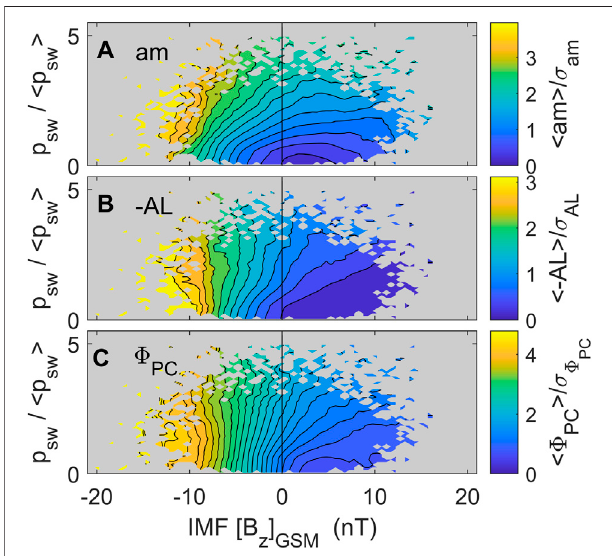
FIGURE 4 | Variations with IMF B Z in the GSM frame and solar wind dynamic pressure, P SW , of: (A) the am planetary geomagnetic index; (B) the − AL auroral electrojet index; and (C) the transpolar voltage, Φ PC . All data are simultaneous with the valid Φ PC samples from 1996 to 2020. The x axis is north-south IMF component ( B Z , de fi ned as positive northward) in the GSM frame of reference and the y axis is the normalized solar wind dynamic pressure, P SW / < P SW > where P SW = m SW N SW V SW2 , m SW is the mean ion mass, N SW is the number density and V SW is the speed of the solar wind. The normalizingfactor < P SW > isthemeanforalldata.The − AL , Φ PC and P SW data are all 15-min boxcar running means of 1-min data whereas the am data are linearlyinterpolatedtothetimeofthehourly Φ PC sampleandthemeanvaluein each B Z - normalized P SW bin, divided by the parameter SD is plotted: the absolute values were presented in Figure 11 of Lockwood and McWilliams (2021a). Grey areas are where data are too sparse for contours to be fi